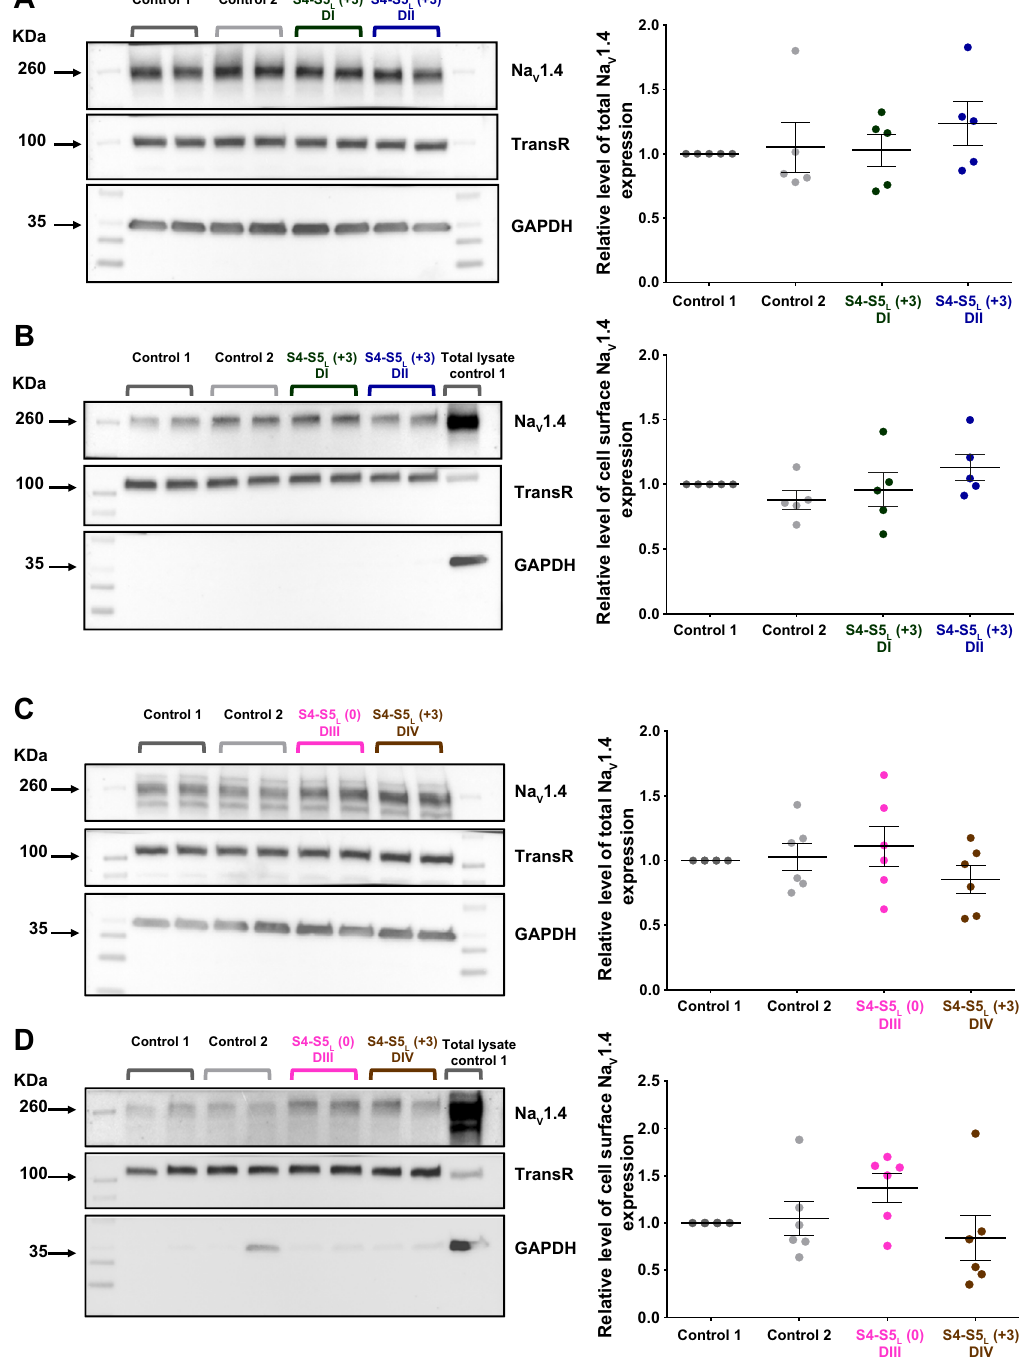
Figure 9. Effect on Na V 1.4 channel expression of S4-S5 L mimicking peptides associated with an increased current density. Left: ( A , C) representative western blots of total Na V 1.4, transferrin receptor (TransR) and GAPDH from transfected COS-7 cells, in the presence of various control and S4-S5 L peptides as indicated. ( B , D) representative western blots of the cell surface fraction of Na V 1.4, transferrin receptor (TransR) and GAPDH from transfected COS-7 cells, in the presence of various control and S4-S5 L peptides. Right: corresponding quantifications of normalized mean ± sem intensities. Band intensities are first normalized to the intensity of the corresponding TransR bands, and ratios are then normalized to control 1 condition. In all condition, p > 0.05. In A–D, the three blots, realized on the same membrane, are cropped. Full-length blots of each tested protein are reported in Supplemental Fig.